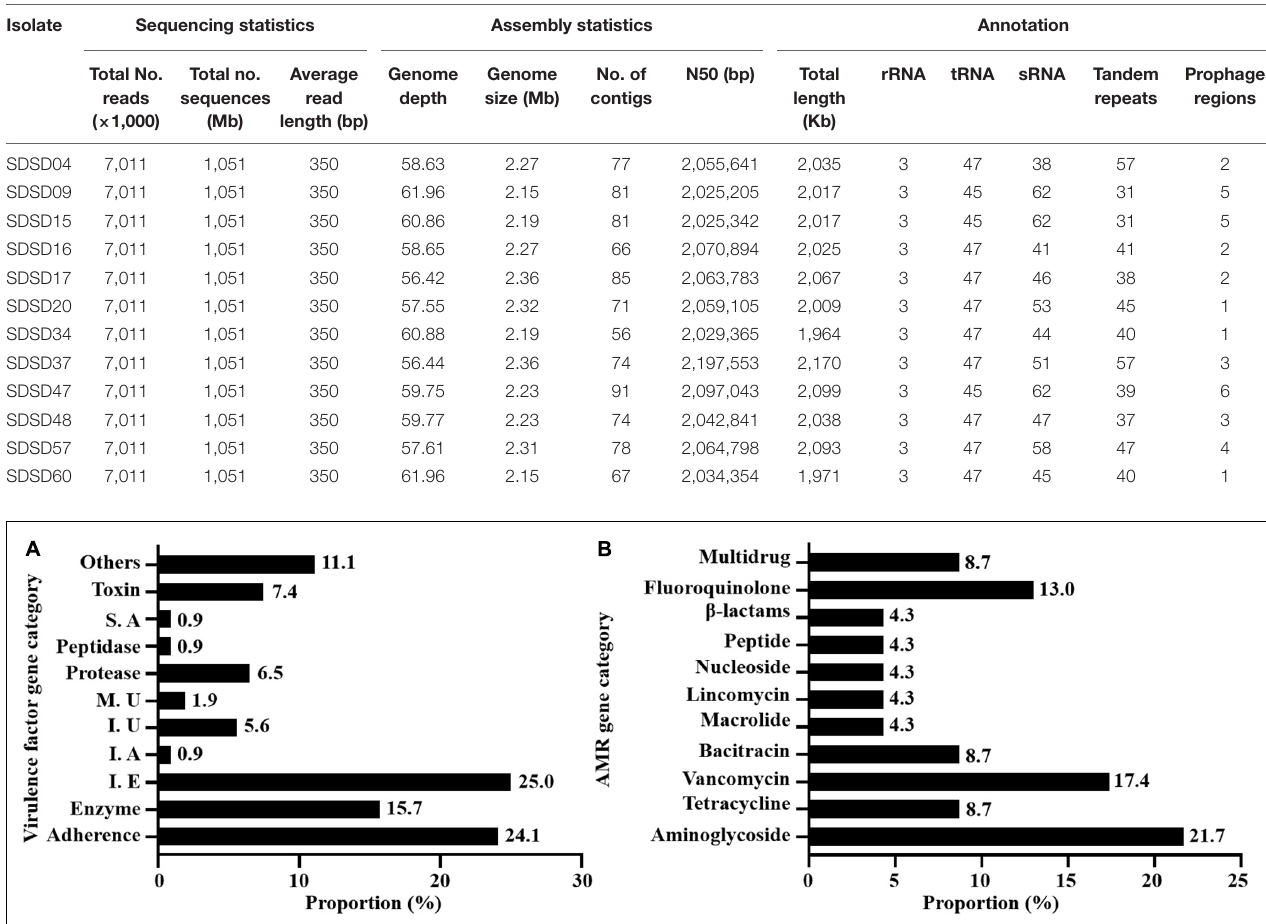
TABLE 3 | Sequencing, assembly statistics and annotation of 12 Streptococcus dysgalactiae subsp. dysgalactiae isolates. Isolate Sequencing statistics